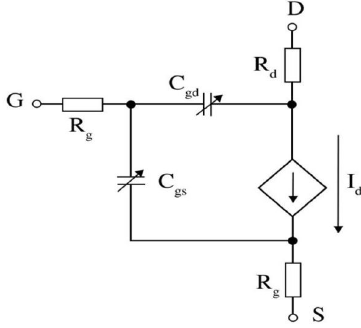
Figure 1: Simulation model of GaN power transistor